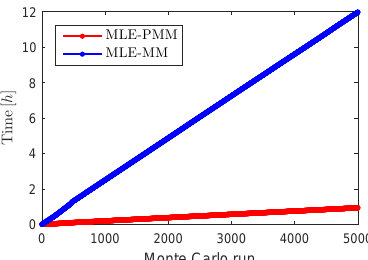
Figure 10. Time consumed by MLE-PMM (red line) and MLE-MM [14] (blue line) algorithms over the Monte Carlo